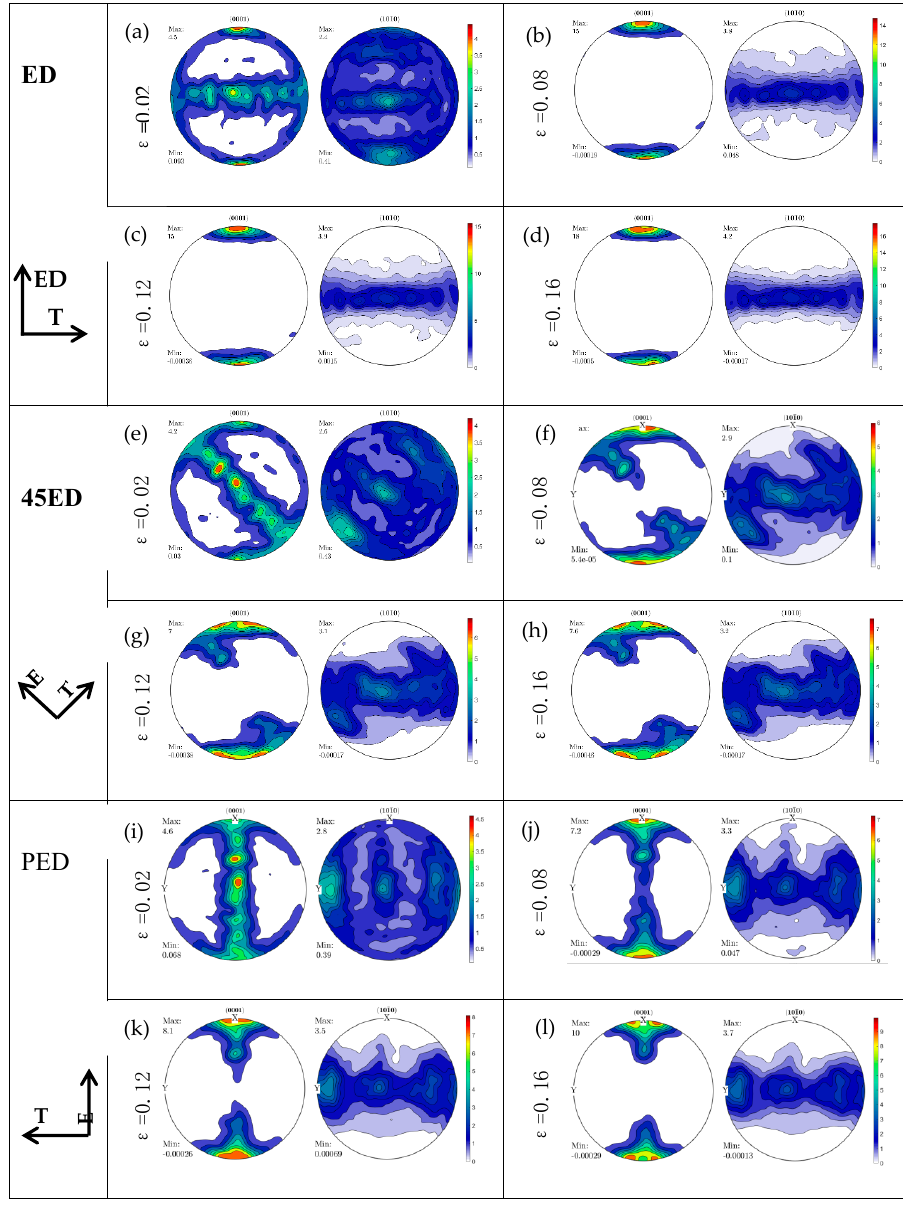
Figure 5. Predicted texture evolutions of various AZ31 alloys samples during compression along different directions at a strain of 0.02, 0.08, 0.12 and 0.16.